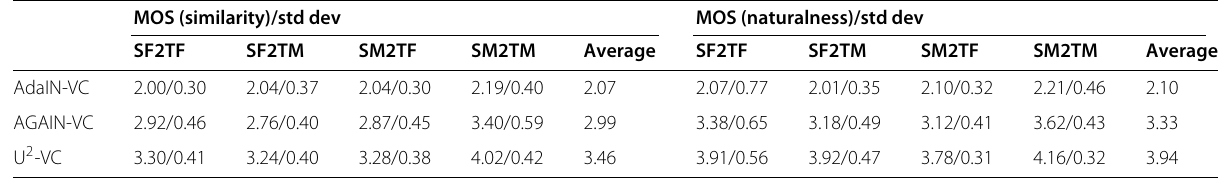
Table 7 Subjective comparison results with standard deviation (std dev) of mono-lingual conversion in seen-to-seen scenario. The results are listd as MOS/std dev